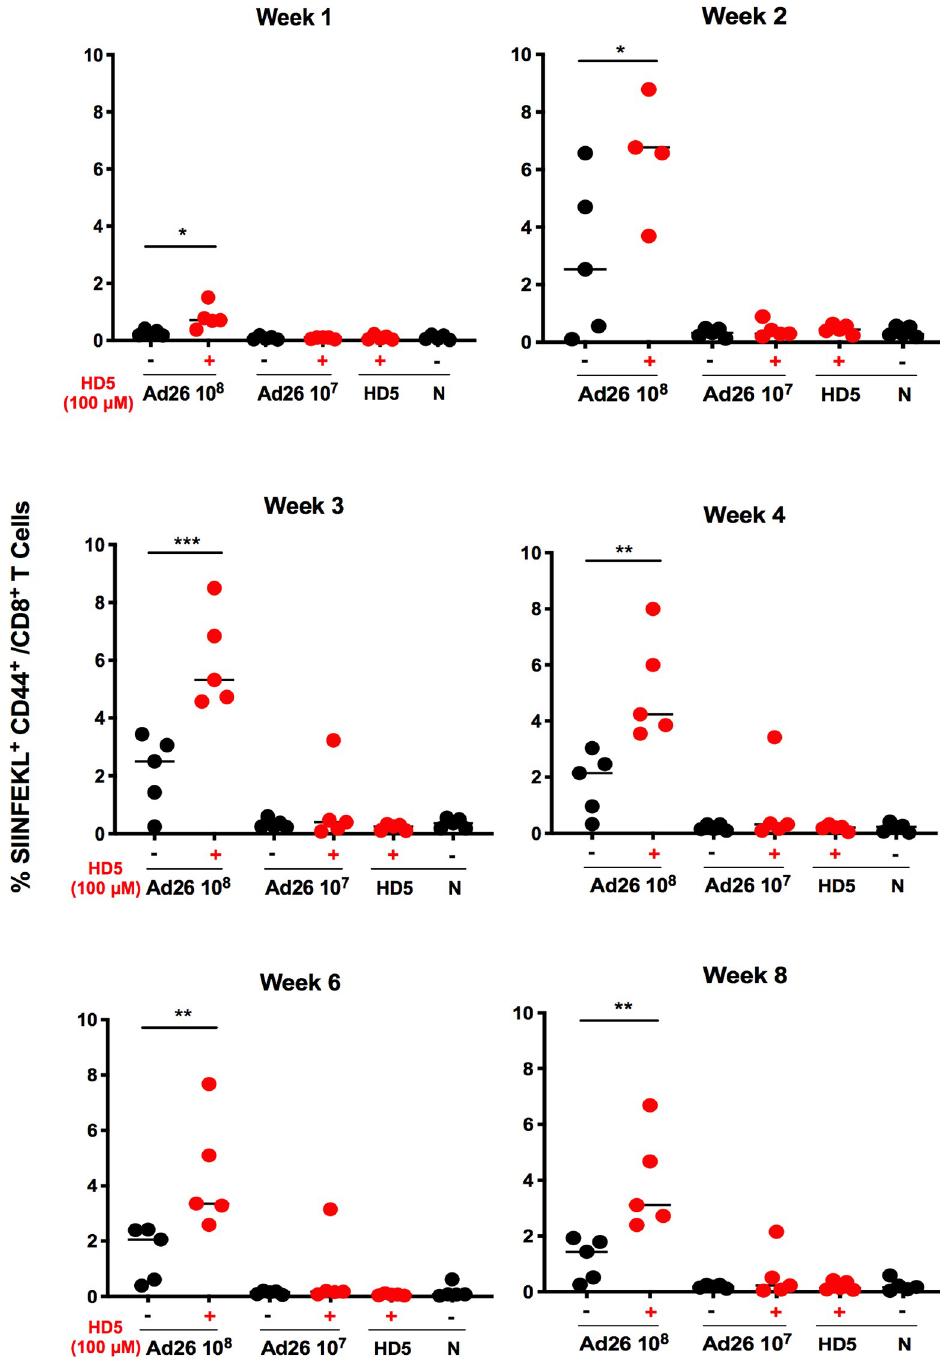
Fig 7. Longitudinal analysis of Ad26-elicicted antigen-specific CD8 + T cell responses. C57BL/6 mice (n = 5/group) were administered i.m. Ad26.SIINFEKL (10 8 - 10 7 vp) pretreated with either PBS or 100 μ M HD5. Mice were bled and SIINFEKL-specific CD8+ T cell responses were measured by H-2K b tetramer staining at (A-F) weeks 1–8 post immunization. The data are representative of experiments performed two times. Mean ± SEM are shown. ��� p < 0.001, �� p < 0.01, � p < 0.05, Mann-Whitney U Test (compared to virus only control).